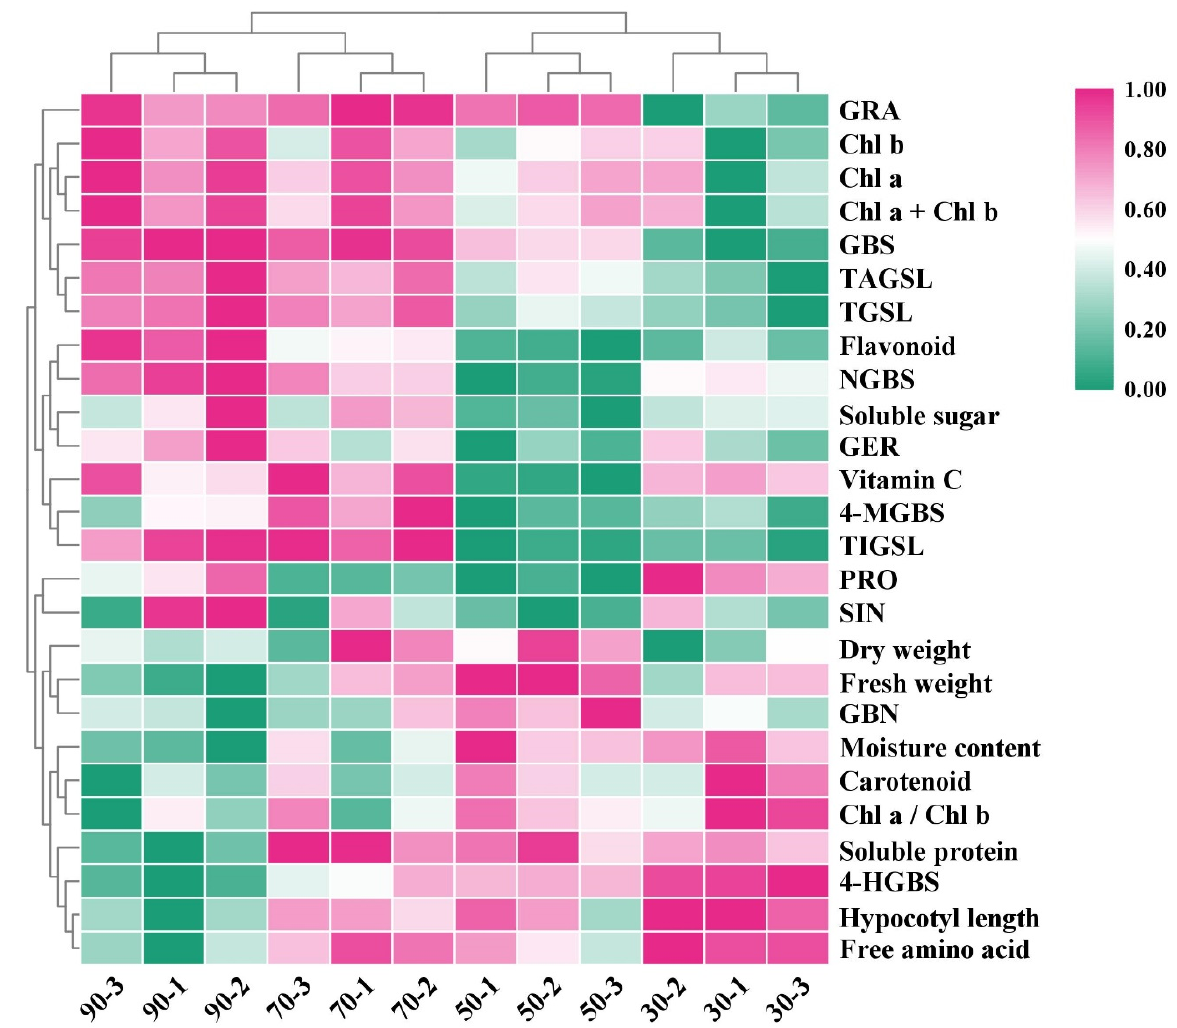
Figure 7. Cluster heatmap analysis summarizing broccoli microgreens responses to light intensity (30, 50, 70, and 90 µ mol · m − 2 · s − 1 ). Pink and green indicate an increase and a decrease of the response parameters, respectively.